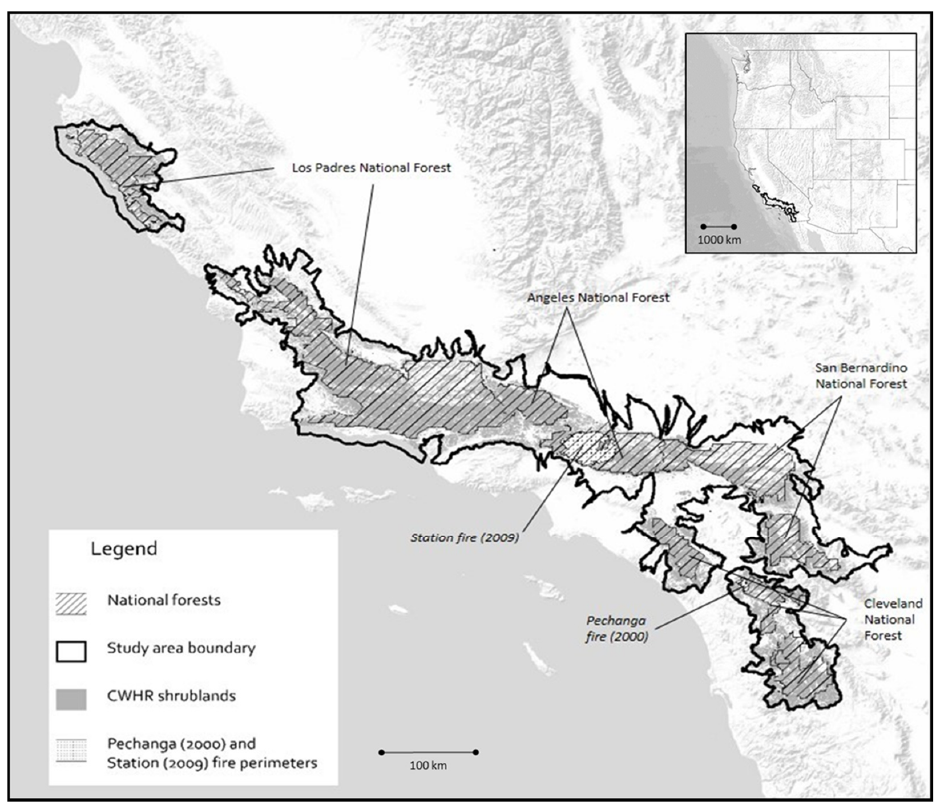
Figure 1. Location of the Southern California study area with California Wildlife Habitat Relation- ships (CWHRs, [38]) shrubland types shown in grey. The Station (2009) and Pechanga (2000) fire perimeters are highlighted.